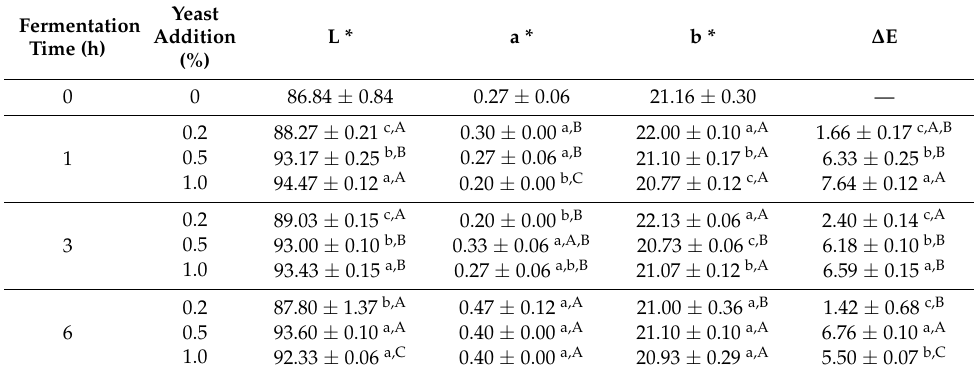
Table 1. Effect of fermentation time and amount of yeast added on the color of dough